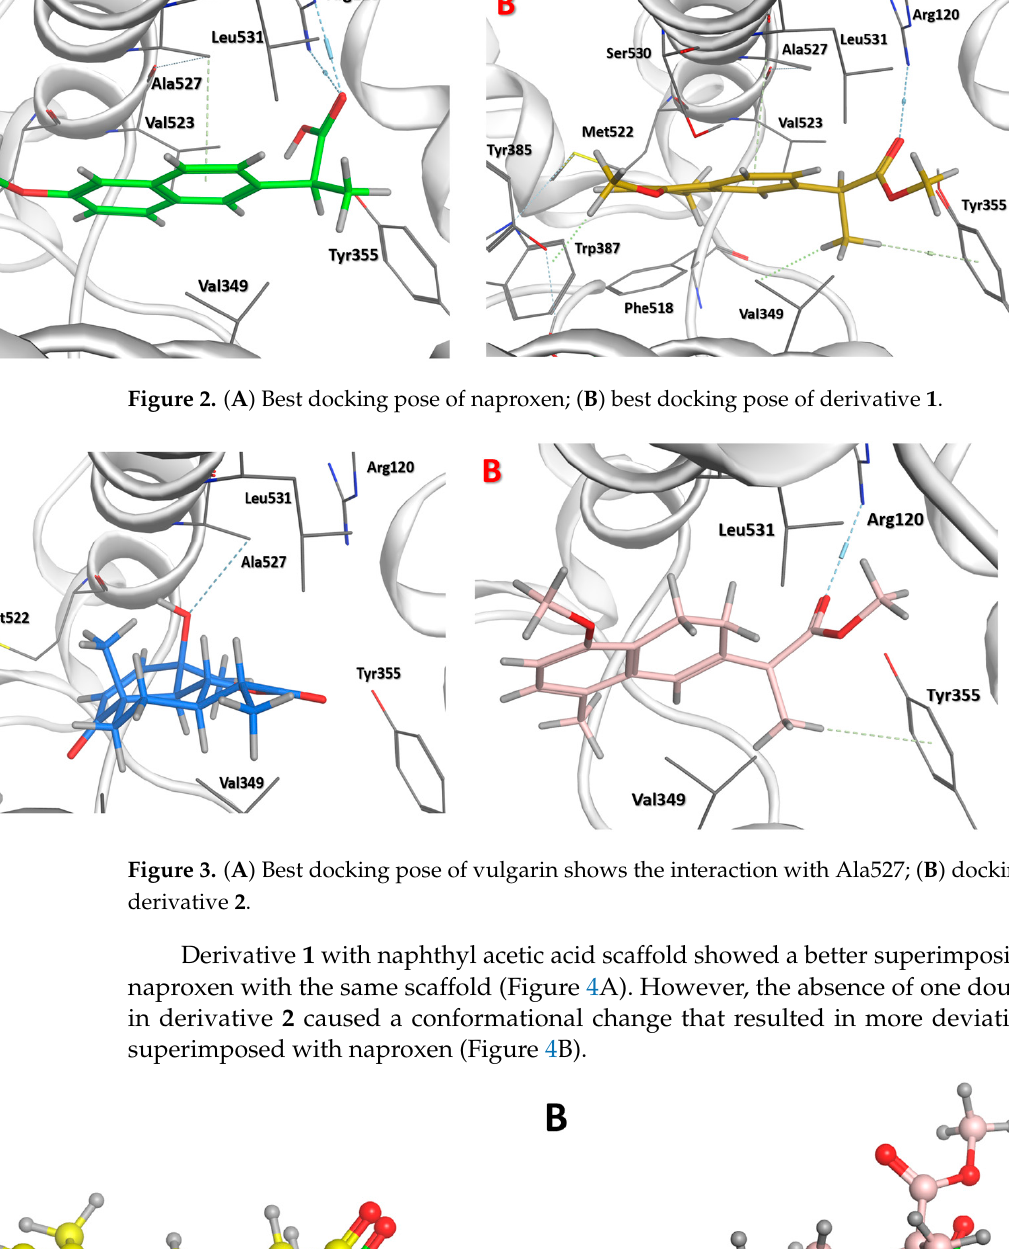
Figure 3. ( A ) Best docking pose of vulgarin shows the interaction with Ala527; ( B ) docking pose of derivative 2 .